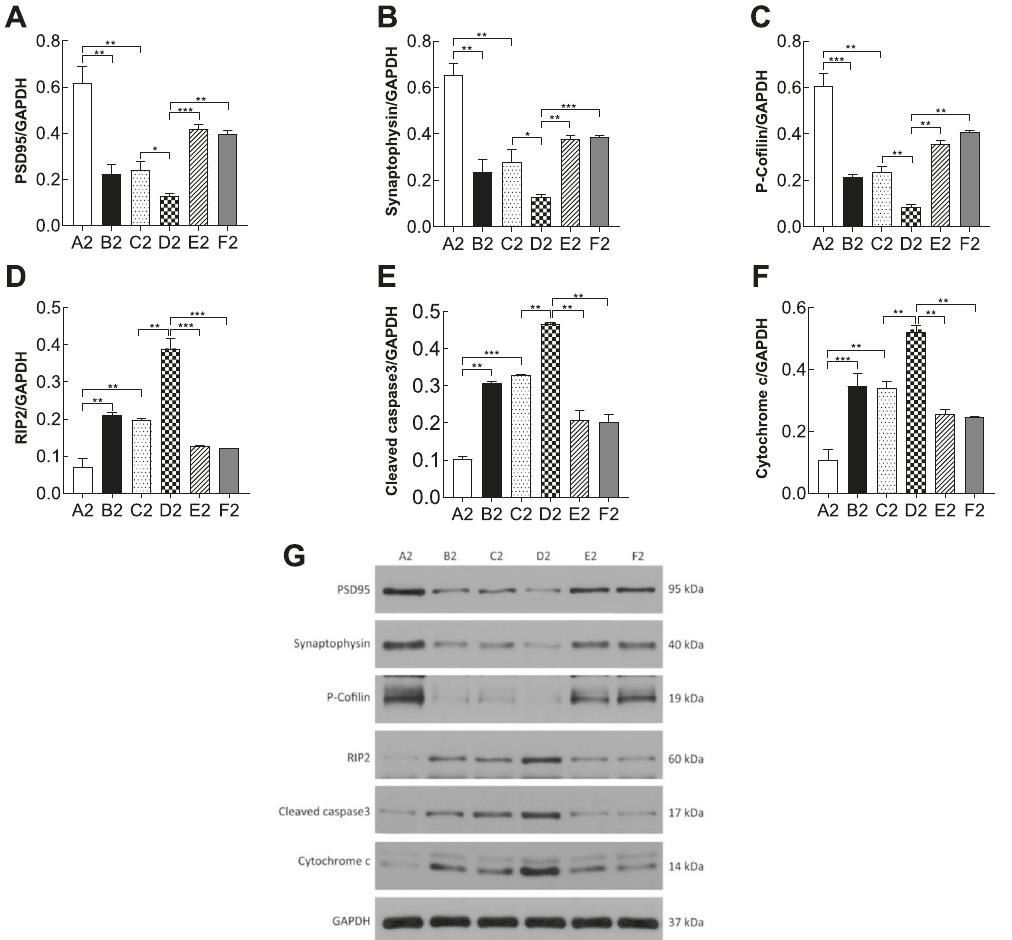
Fig. 8 Statistical analysis of Western blot pro fi les in hippocampal neurons ( n = 3). A PSD95. B Synaptophysin. C P-co fi lin. D RIP2. E Cleaved caspase-3. F Cytochrome c. G PSD95, synaptophysin, P-co fi lin, RIP2, cleaved caspase-3, cytochrome c /GAPGH expression levels in hippocampal neuronal cells were detected using western blotting. A similar effect was observed in hippocampal neurons to that observed in prefrontal cortical neurons. Error bars represent the mean ± SD. * P < 0.05, ** P < 0.01, *** P < 0.001, **** P < 0.0001. Con control, OGD oxygen- glucose deprivation, CS corticosterone. A1: Con; B1: OGD; C1: CS; D1: OGD + CS; E1: OGD + CS + re-p75NTR; F1: OGD + CS + siJNK1; A2: Con; B2: OGD; C2: CS; D2: OGD + CS; E2: OGD + CS + re-p75NTR; F2: OGD + CS +